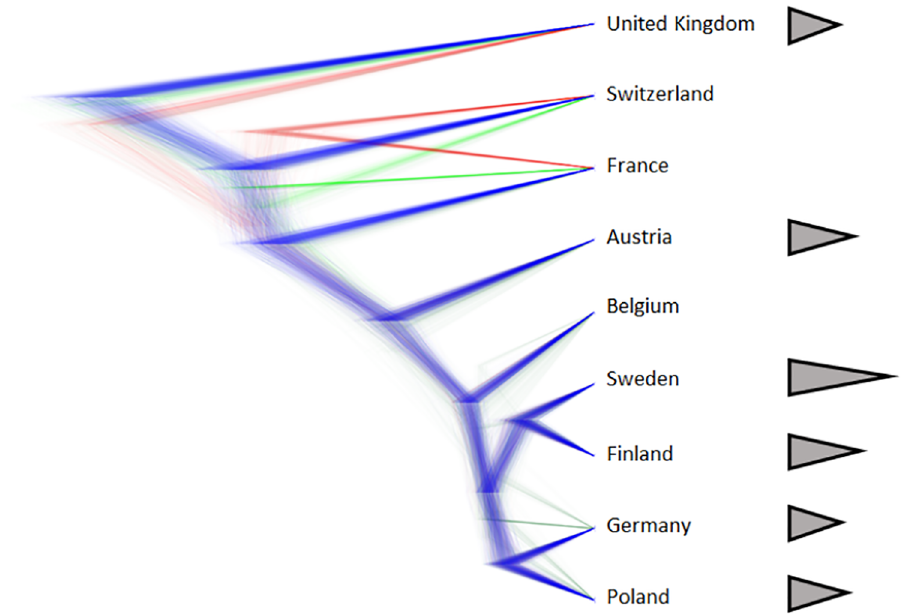
Fig 2. Relationships among the 9 sampled Leucorrhinia dubia populations across Europe based on 1674 SNPs from ddRAD sequence data. Thin lines represent densitiesthat represent the branches. Alternative topologiesare drawn in different color, where blue represent the most supportive, followedby red and green. The trianglesto the right represent cartoons of larval spine length showingthe proportional differences in length. Note that in reality the longestspines are also wider at the